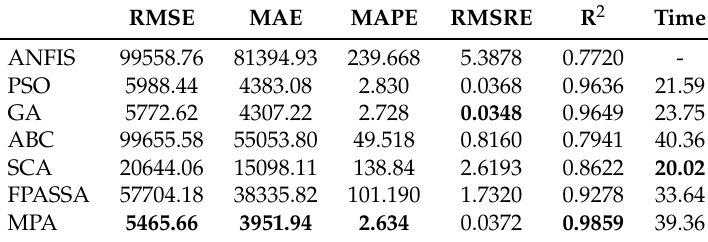
Table 5. Results of Italy.